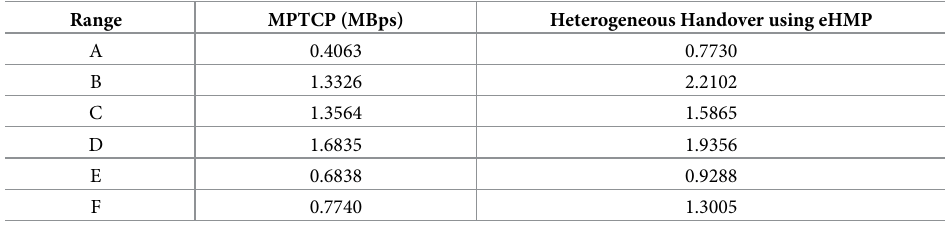
Table 3. Average throughput of MPTCP and heterogeneous handover using eHMP in each range.